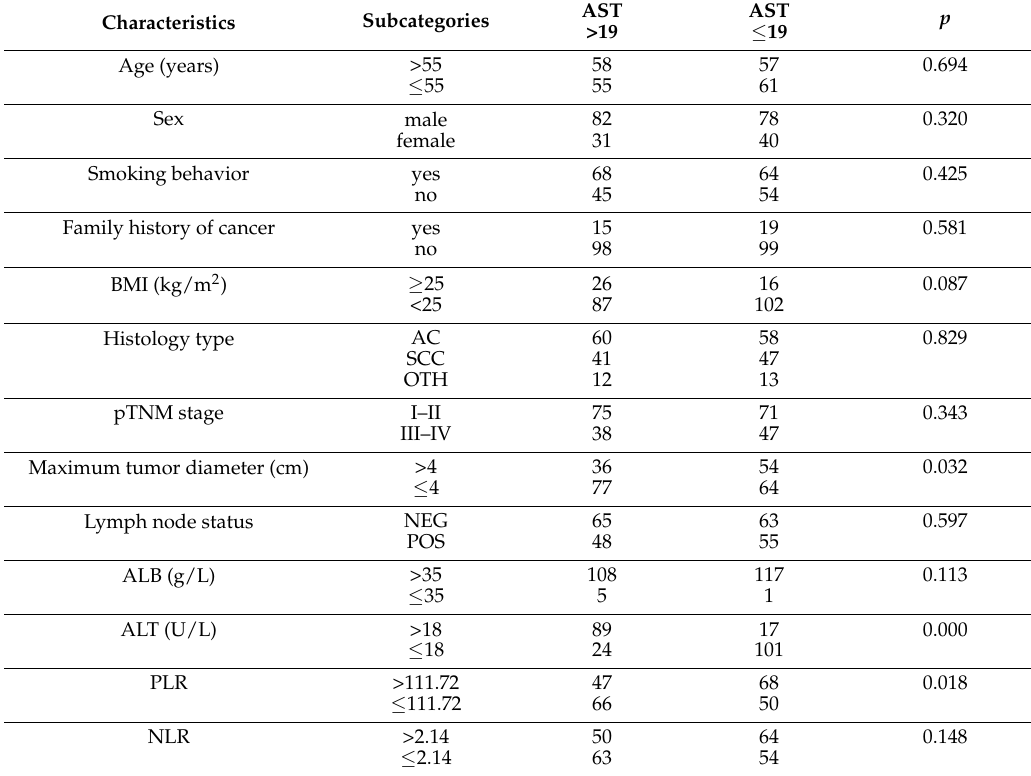
Table 5. Comparison of clinical characteristics of patients with different AST ( χ 2